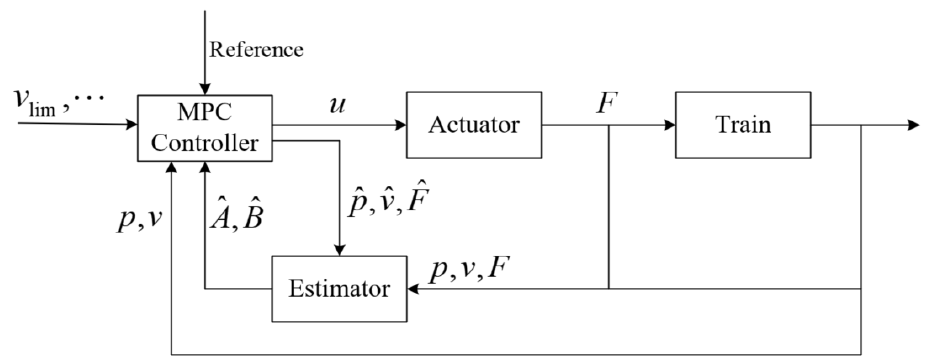
Figure 4. Adaptive MPC control